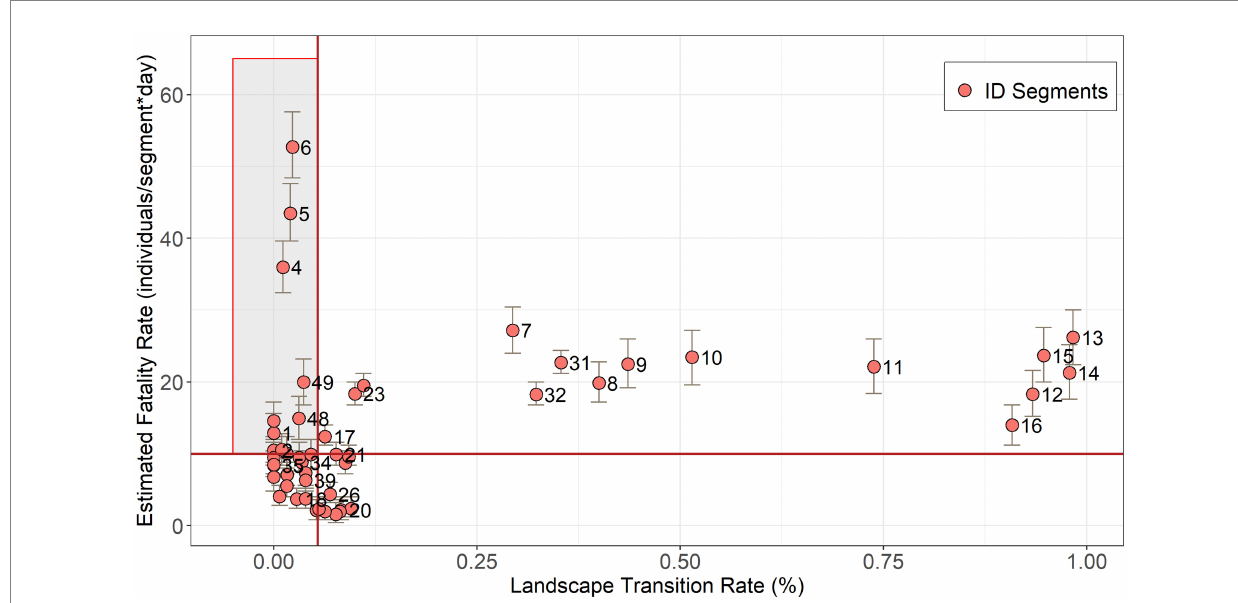
FIGURE 4 Segment prioritization to receive mitigation actions for amphibian roadkills, based on fatality estimation and landscape stability. The red lines are the threshold defined by the median values of the land-cover transition rate (5% of landscape transition) and the fatality estimate (9.99 individuals per day). Priority segments are within the shaded box. Numbers correspond to segment IDs and bars to the credibility intervals of fatality estimates (Supplementary material